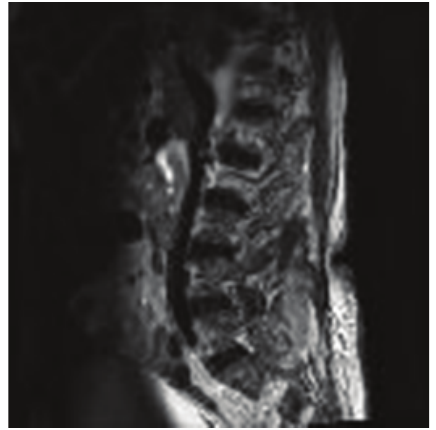
Figure 2: MRI: sagittal thoracolumbar spine